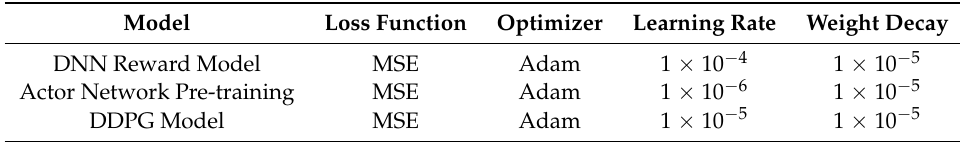
Table 1. Training parameters in the